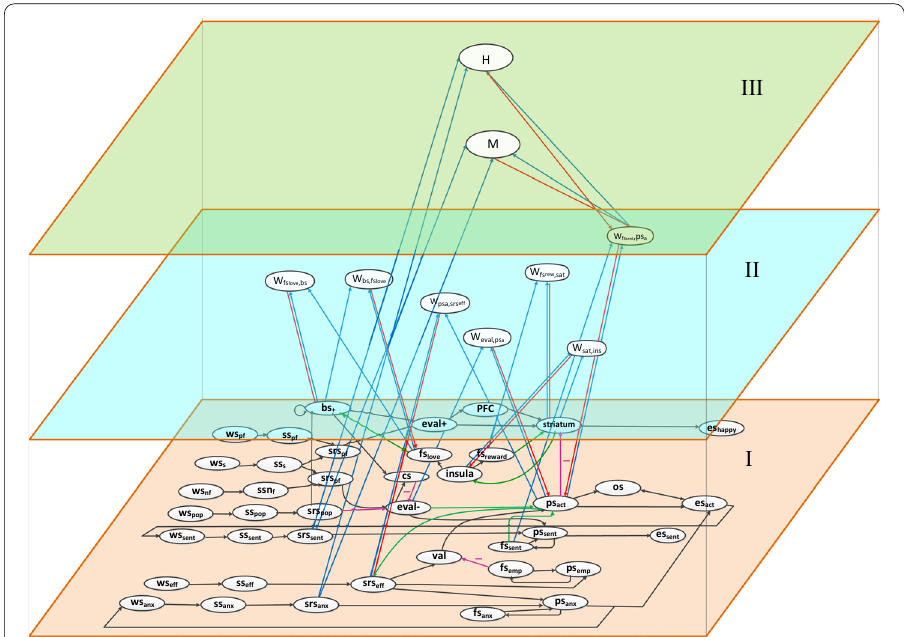
Fig. 1 Reified second-order adaptive network architecture for a narcissist person, consisting three levels: base level I, first-order adaptation level II and second-order adaptation level